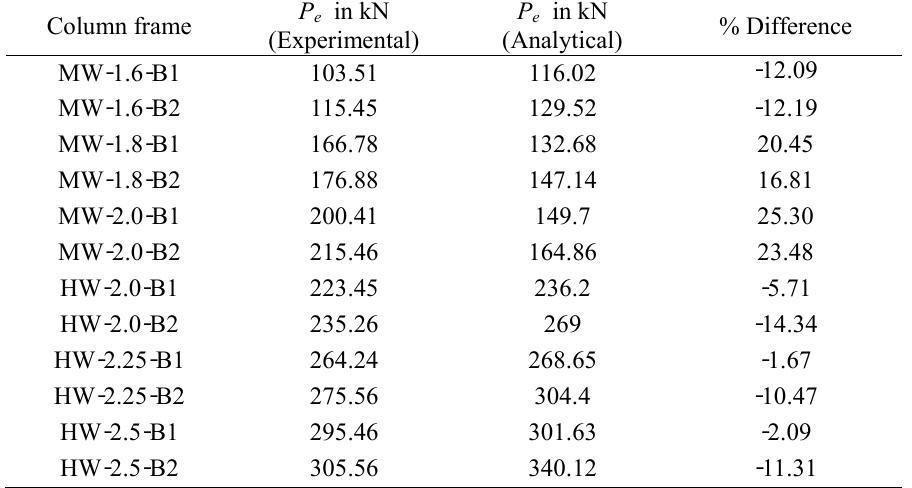
Details of the elements used for finite element analysis [12]. Part of frame Element Description 4-noded, quadrilateral, stress/displacement shell element with S4R reduced integration and a large-strain formulation 8-noded general purpose linear brick element, with reduced integration (1 integration point) and hourglass control. 8-noded general purpose linear brick element, with reduced integration (1 integration point) and hourglass control. 8-noded general purpose linear brick element, with reduced integration (1 integration point) and hourglass control. Validation of FE model with experimental study by Sangle et al. [8].